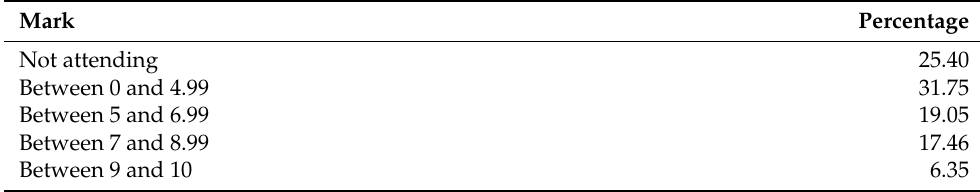
Table 4. Final results of Industrial Engineering